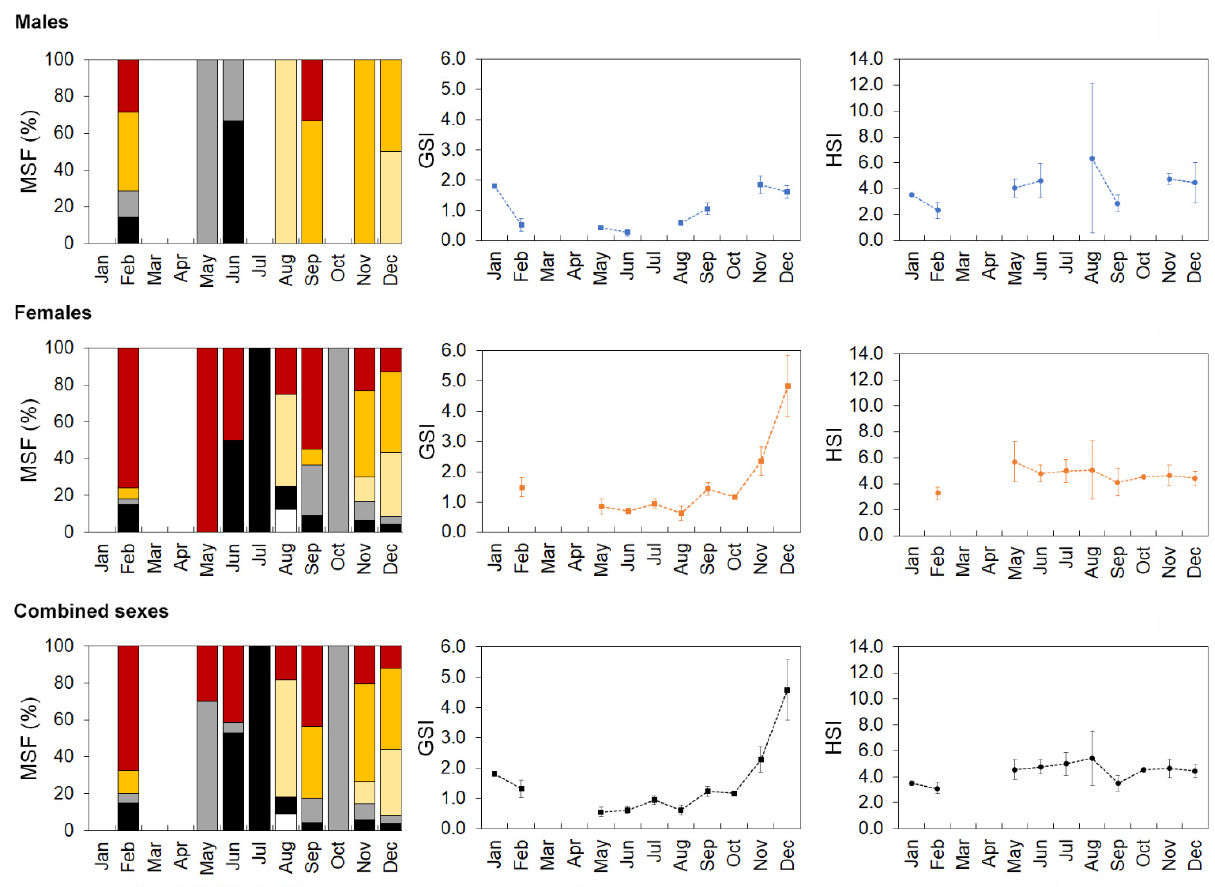
Figure 8. Monthly distribution of the maturity stage frequency (MSF), gonadosomatic index (GSI), and hepatosomatic index (HSI) for Mora moro analyzed from the commercial catches (2005–2017) in the Azores. 0—immature, I—resting, II—developing–beginning and the development of maturation, III—pre-spawning, IV—spawning–running, and V—spent. GSI and HSI are represented as mean value ± 0.95 confidence interval.